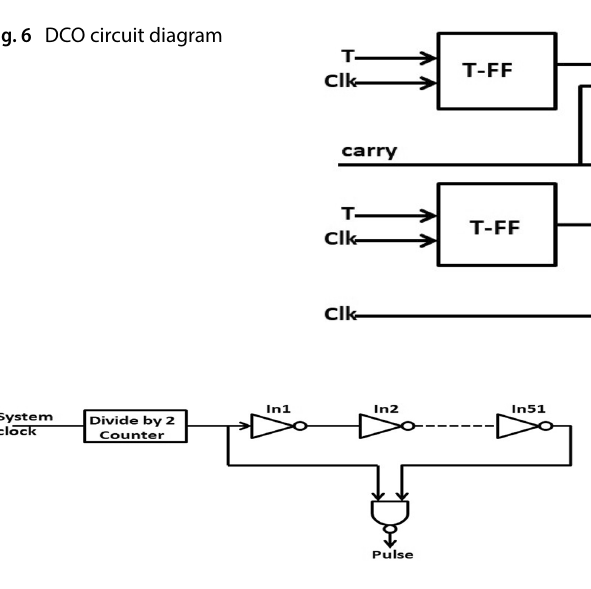
Fig. 8 General architecture for the proposed ring oscillator [10]